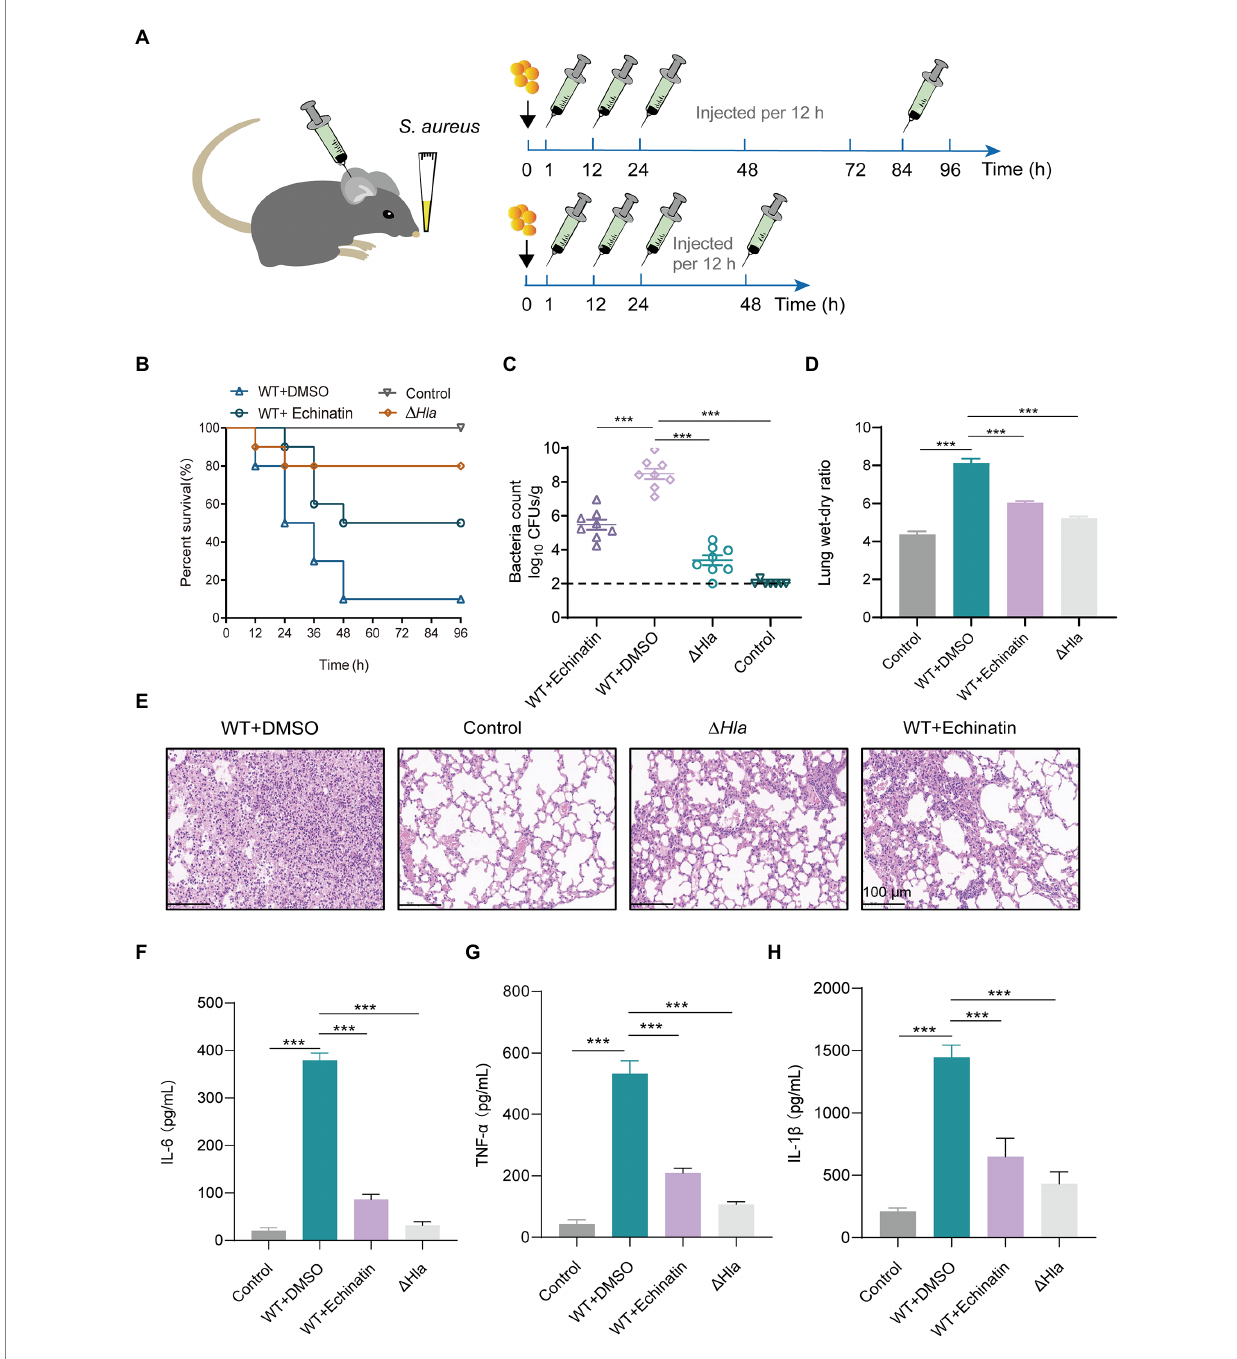
FIGURE 5 Echinatin protects against S. aureus pneumonia infection in mice. (A) Flow chart for the establishment of an S. aureus -induced pneumonia infection model in mice. S. aureus USA300 (2 × 10 8 or 1 × 10 8 CFU/mouse) or PBS was used to infect C57BL/6J mice via nasal drops, and mice were then treated with echinatin (60 mg/kg, i.h.) or DMSO (as a vehicle) to assess the therapeutic effect on S. aureus -induced pneumonia. (B) The survival rate of mice in each group was monitored at 12 h intervals for 96 h ( n = 10). (C) Bacterial burden in the lung was determined after treatment with or without 60 mg/kg echinatin ( n = 8). (D) Measurement of wet/dry weight ratios in the lungs of S. aureus -infected mice after echinatin treatment revealed the extent of lung damage. (E) Histopathological analysis of mouse lungs harvested after infection with S. aureus in the presence or absence of echinatin. Scale bar = 100 μ m. (F–H) The levels of TNF- α , IL-1 β , and IL-6 in bronchoalveolar lavage fluid (BALF) were determined by ELISAs. The data are presented as the mean ± SD. * p < 0.05, ** p < 0.05, and *** p <